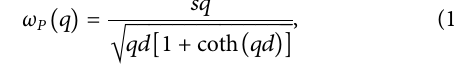
Frontiers in Physics |